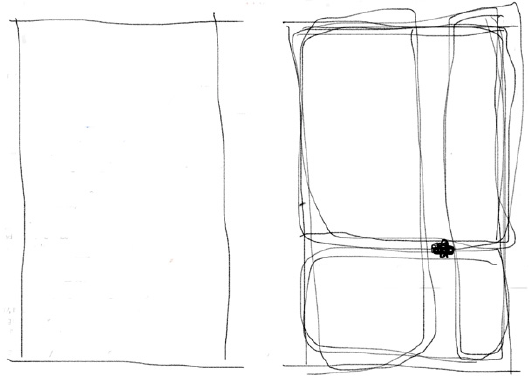
Figure 5. Alexander provides the simple example of a blank sheet of paper (left) with a dot added (right). This “symmetry-breaking” creates new regions within the rectangular piece of paper, which are overlapping and interrelated to one another within an inseparable geometric whole. (Redrawn by the author.).